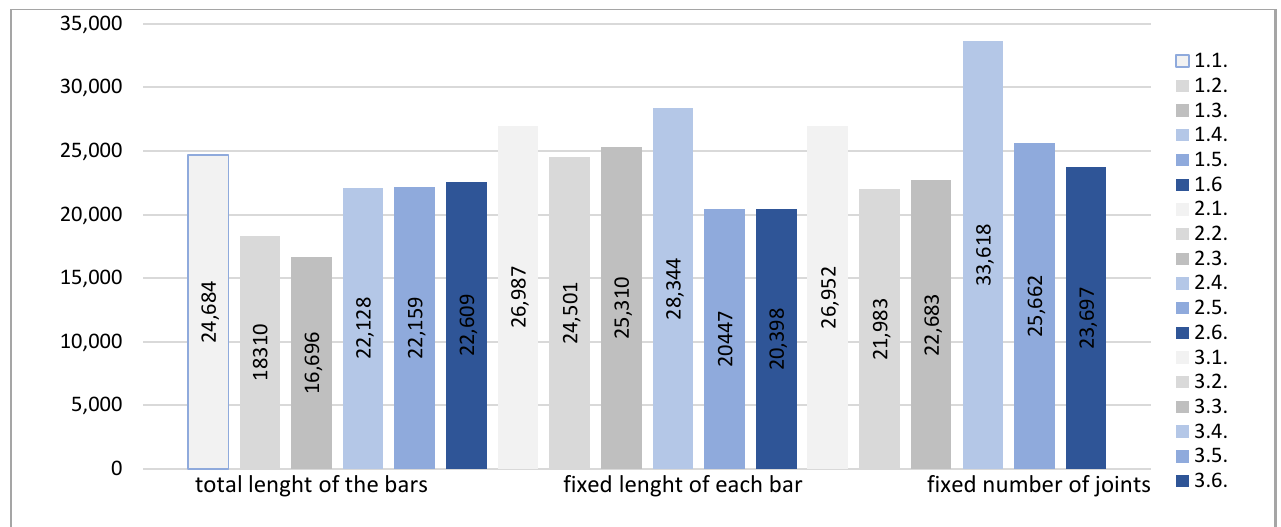
Figure 8. Geometries are generated according to Finding a 3-fixed number of joints (left – rectangular, right triangular). Both meshes present a smooth surface with less dense mesh (authors compilation).